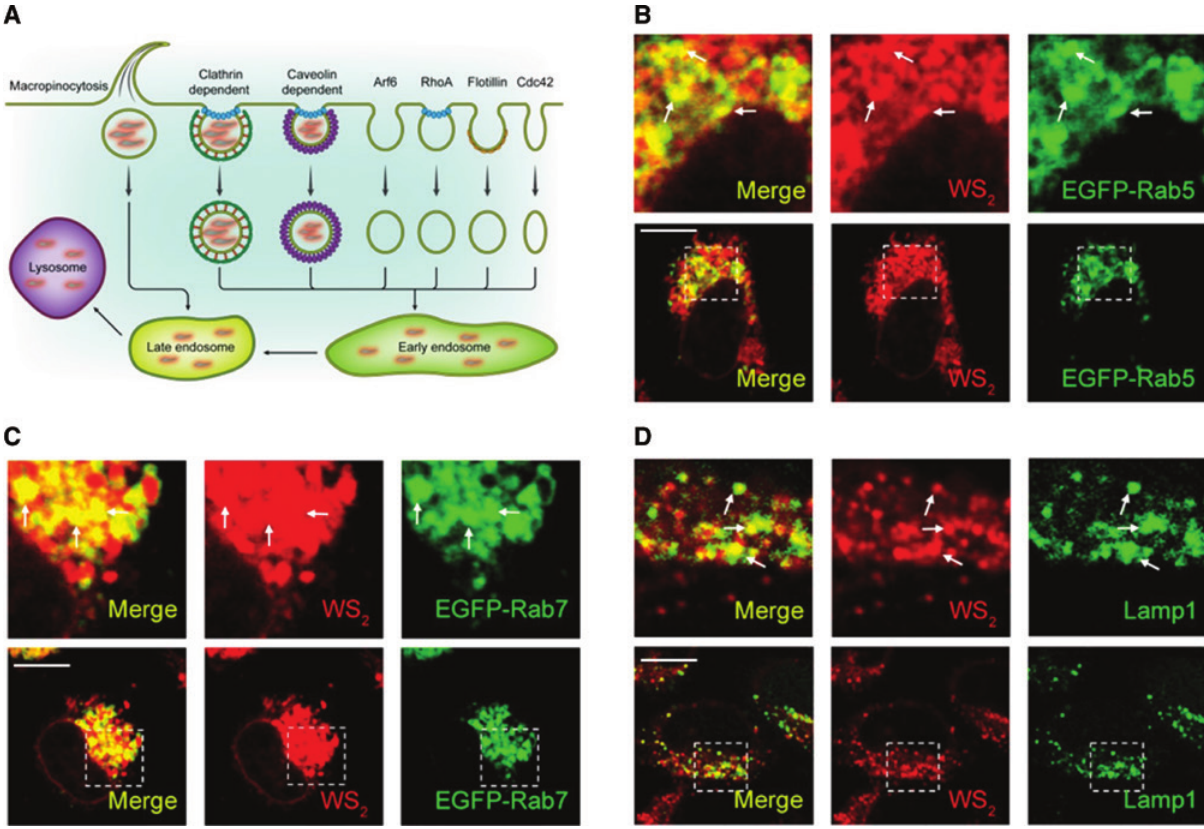
NSs in lysosome. Figure 4: Accumulation of WS 2 Schematic diagram of internalization pathways of WS NSs in (A) HeLa cells. (B) HeLa cells were transfected with EGFP-Rab5 plasmid, and 2